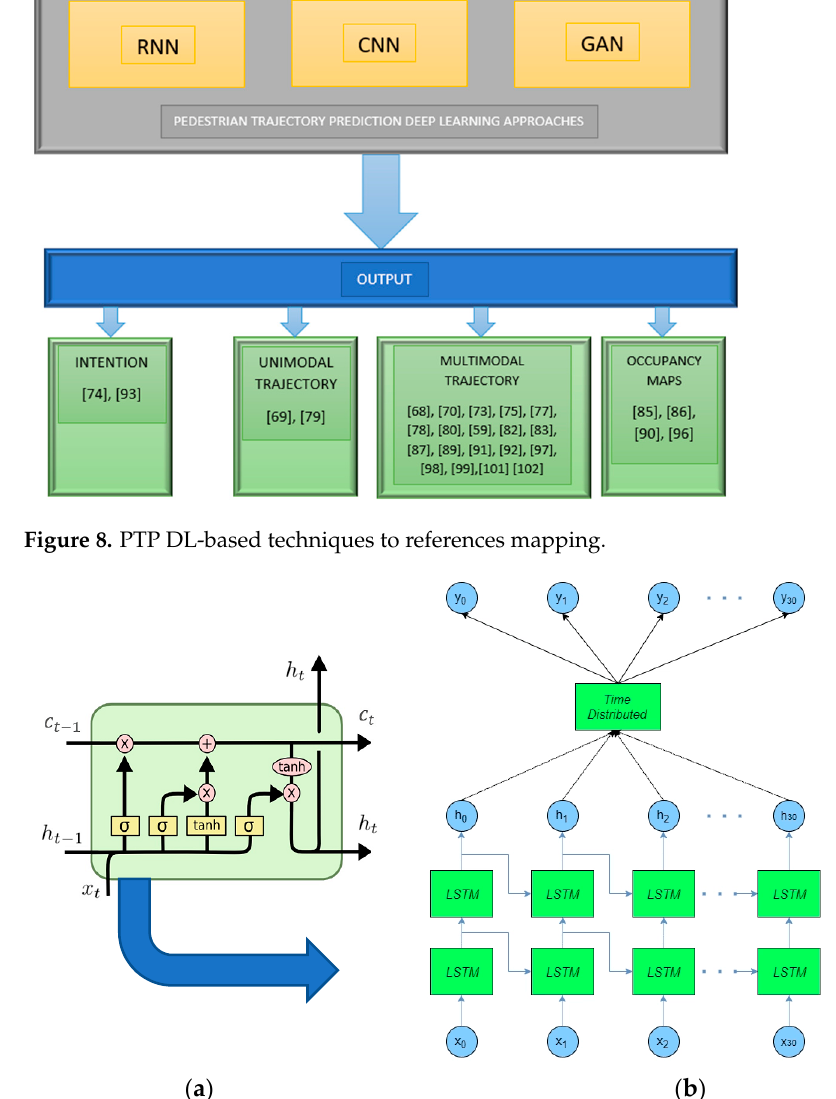
Figure 9. ( a ) LSTM cell. ( b ) Deep RNN using LSTM.